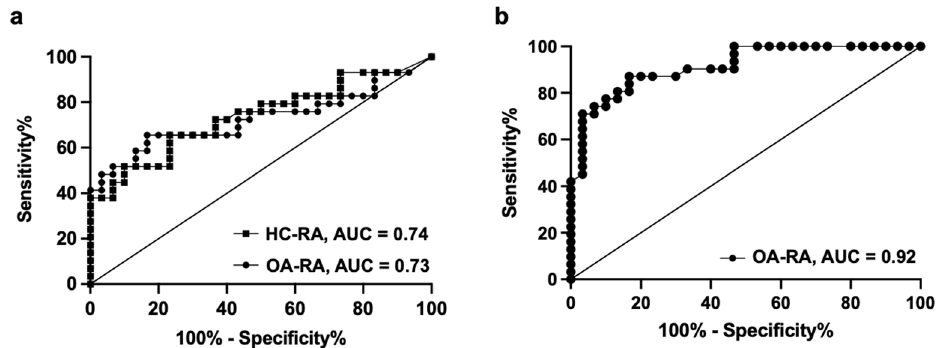
Figure 2. The receiver operating characteristic (ROC) curve of apurinic/apyrimidinic endonuclease 1/redox factor-1 (APE1/Ref-1) levels in serum and synovial fluid (SF) of rheumatoid arthritis (RA) patients. ( a ) The ROC curve from serum samples of patients with osteoarthritis (OA) and RA resulted in an area under the curve (AUC) of 0.73, and that of healthy control (HC) patients and RA patients resulted in an AUC of 0.74. ( b ) The ROC curve from SF samples of patients with OA and RA resulted in an AUC of 0.92.